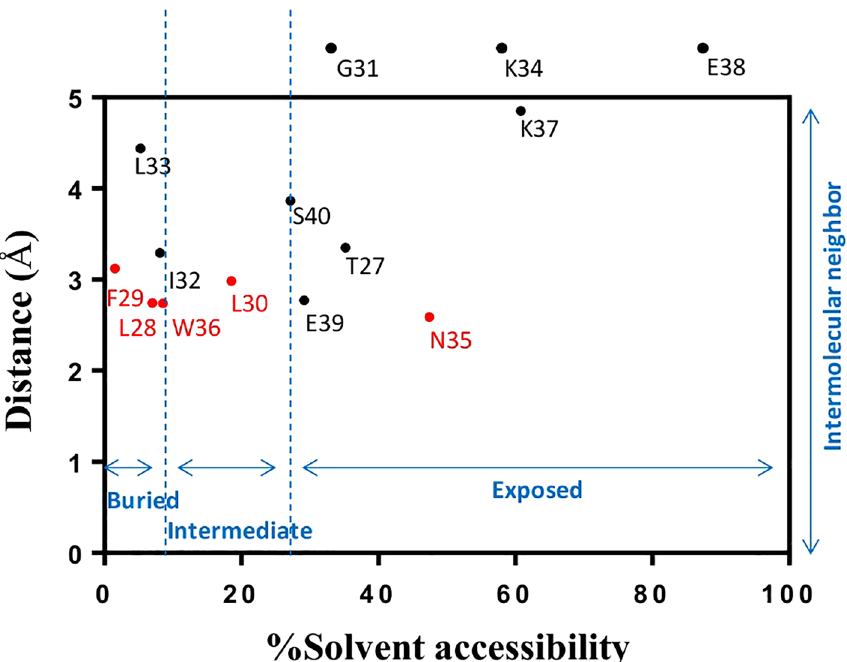
Figure 4. Solvent accessibility, intermolecular neighbors, and hydrogen bond properties of 27 TLFLGILKNWKEES 40 in IFN-γ. The red color represents hydrogen bonding.